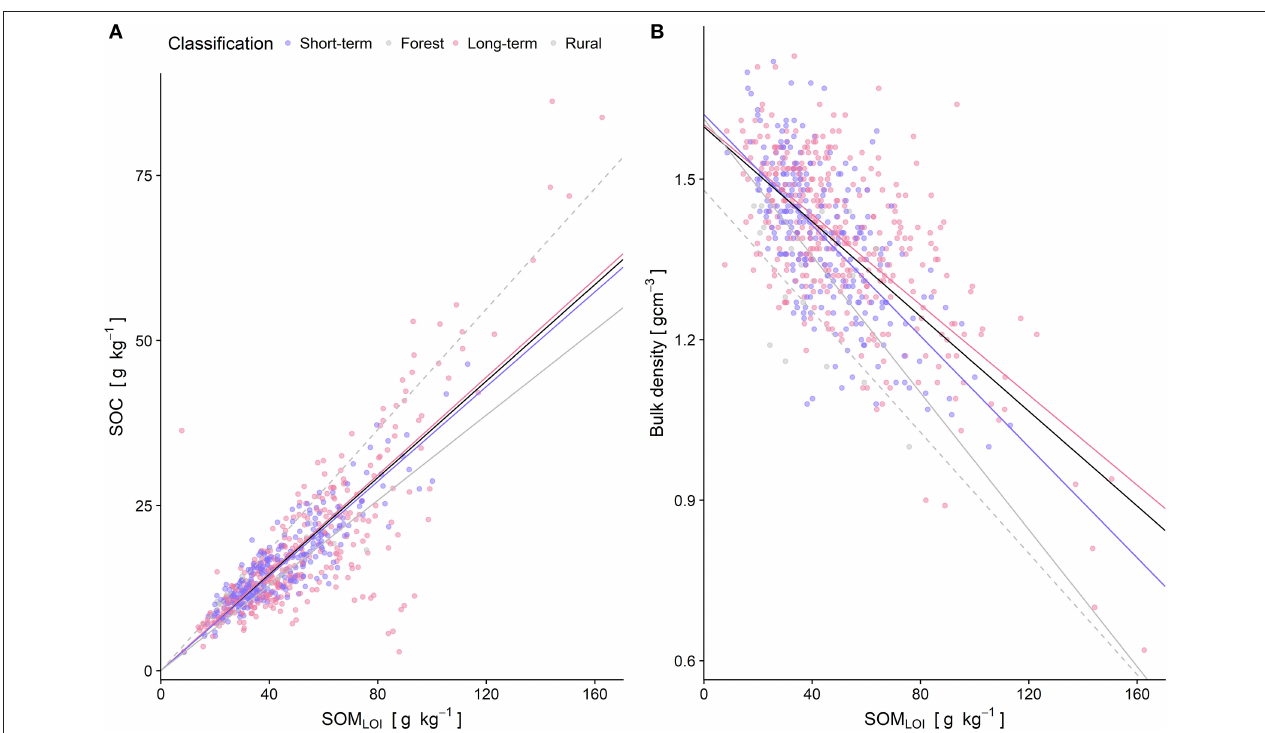
FIGURE 10 | Relationships between (A) the concentrations of SOC, soil organic carbon; and SOM LOI , soil organic matter obtained from loss on ignition in the fine earth, (B) Bulk density and concentration of SOM LOI in the fine earth. The black line represents the linear relationship for forest, rural and the urban soils, the pink line represents the long-term urban soil, the violet line represents the short-term urban soil, the gray dash line represents rural arable soils, and the gray thick line represents forest